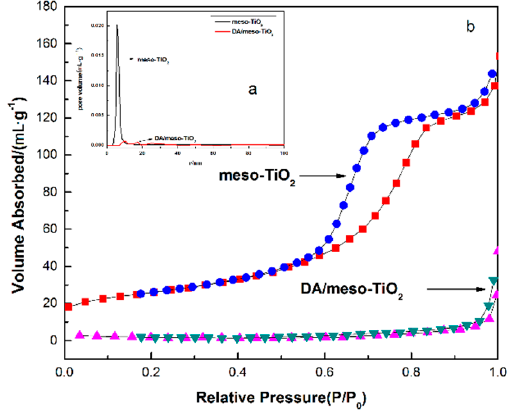
Figure 4. ( a ) The corresponding pore size distribution curve and ( b ) nitrogen adsorption–desorption isotherms obtained from the desorption branch of the nitrogen isotherm of meso-TiO 2 and DA/meso-TiO 2 . Table 2. The results of nitrogen adsorption–desorption.